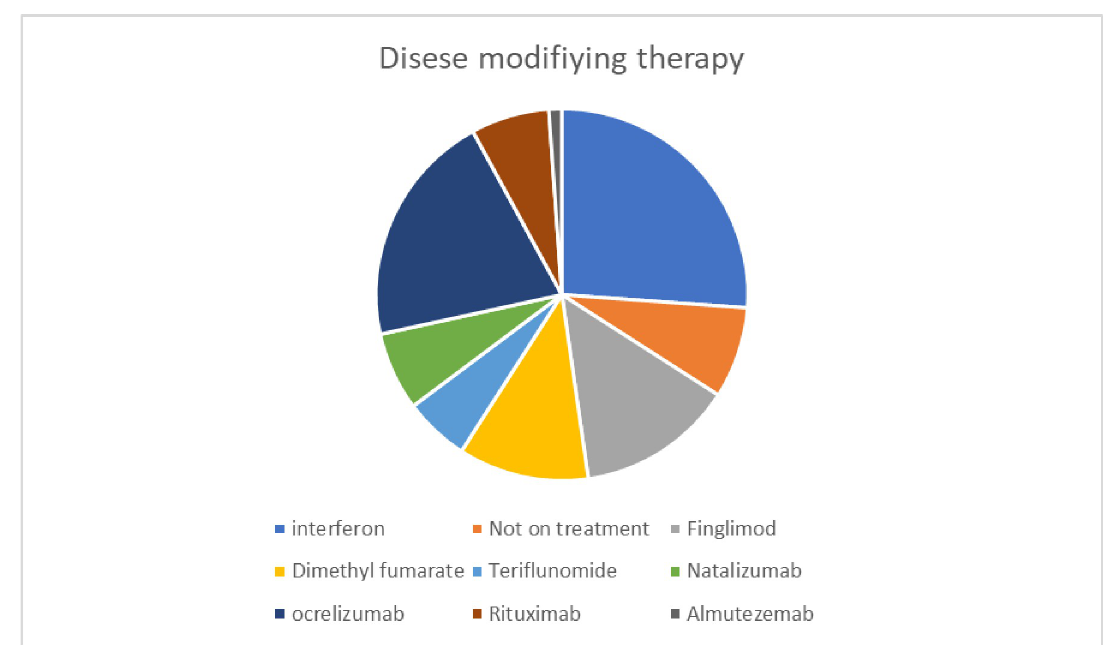
Fig 1. Types of disease-modifying therapy used by